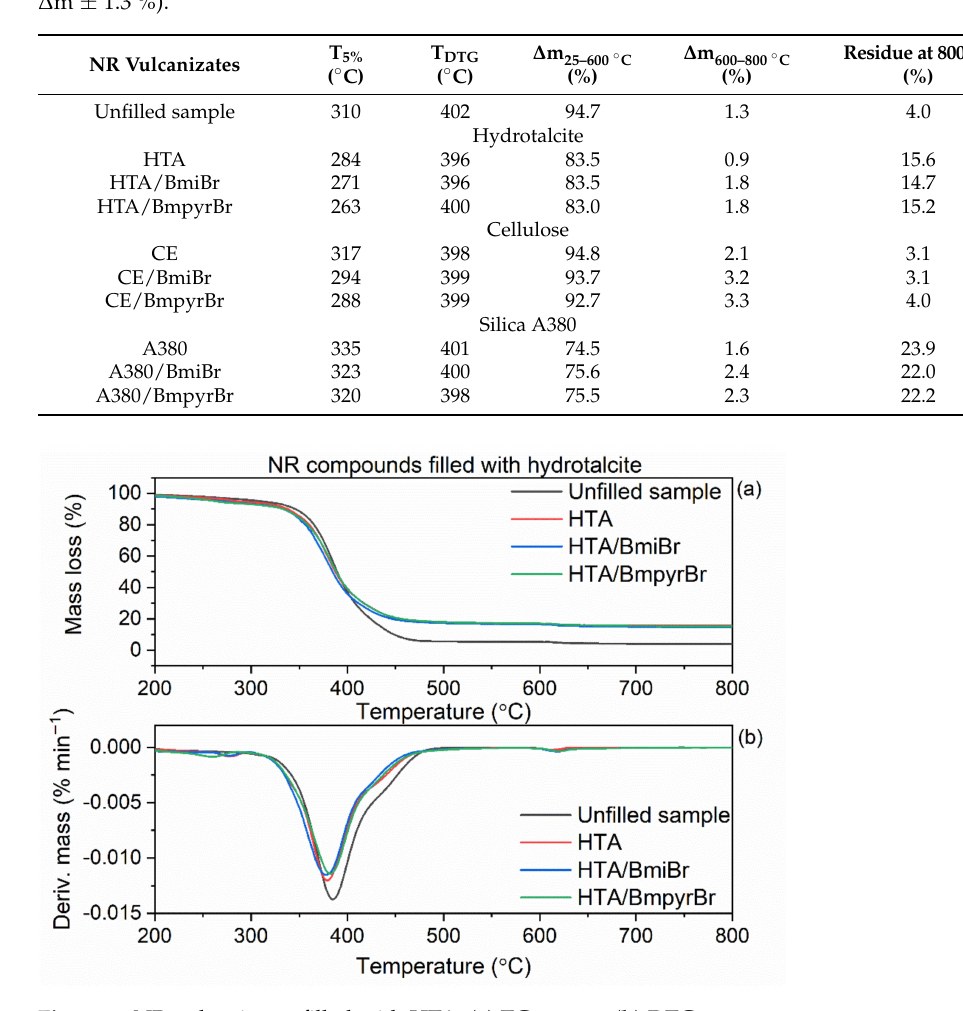
Figure 8. NR vulcanizates filled with HTA: ( a ) TG curves; ( b ) DTG curves.